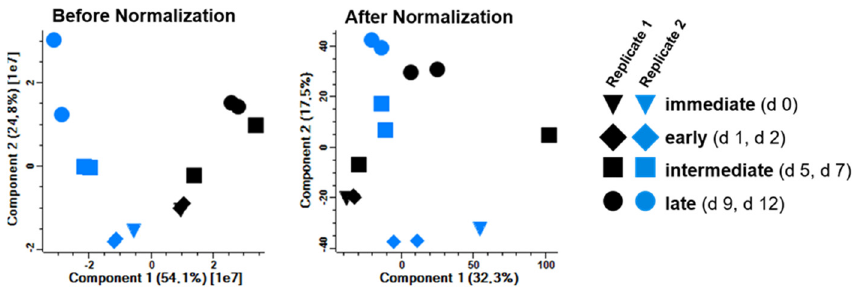
Figure 7. Principal component analysis (PCA). Quantitative MS data of both replicates were subjected to PCA analysis before and after normalization. Before normalization, sample clustering is dominated by animal-to-animal variability. Normalization partially compensated for these effects and resulted in a more time-dependent clustering of immediate, early, intermediate, and late samples from both animals.